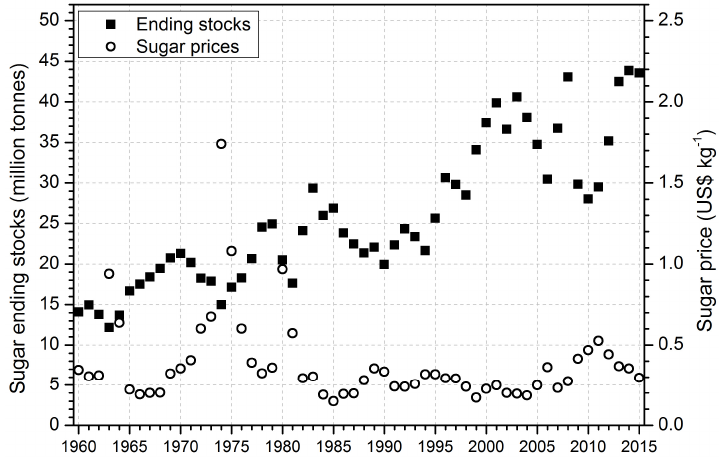
Figure 1. World centrifugal sugar ending stocks and sugar prices from 1960 to 2015. Source: [4,5].